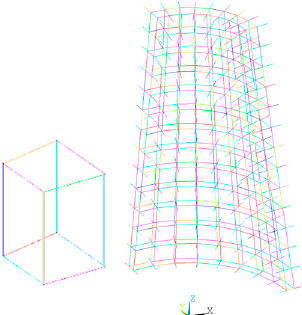
Figure 11. Unit Cell and cells of the 1st quarter.